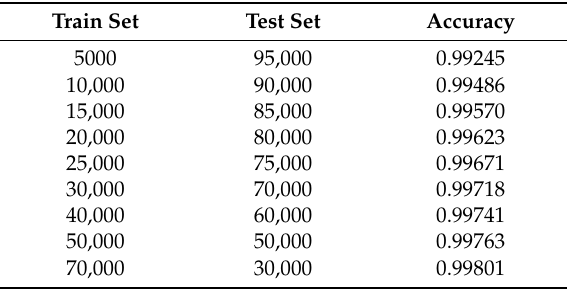
Table 2. Accuracy vs size of training data.